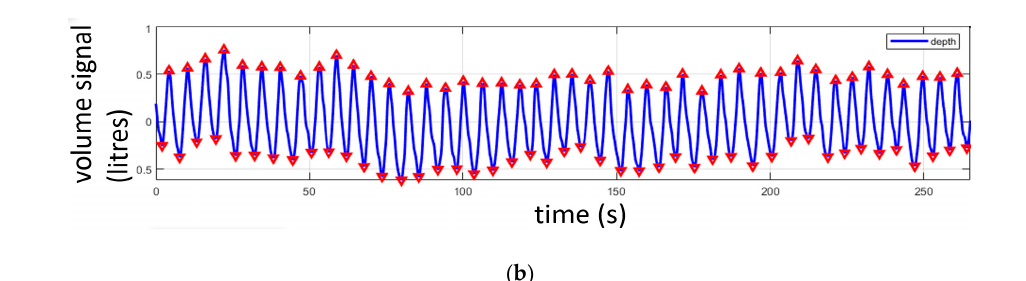
Figure 2. ( a ) Depth camera system schematic illustrating the field of view (FOV) and region of interest (ROI) and the processing of the ROI information to produce the respiratory volume (RV) signal. T is the length of a time window used in the calculation of respiratory rate. ( b ) Respiratory volume signal acquired from a heathy volunteer using a Kinect TM V2 depth camera (Microsoft, Redmond, WA, USA). Triangles indicate the peaks and troughs of the signal modulations.